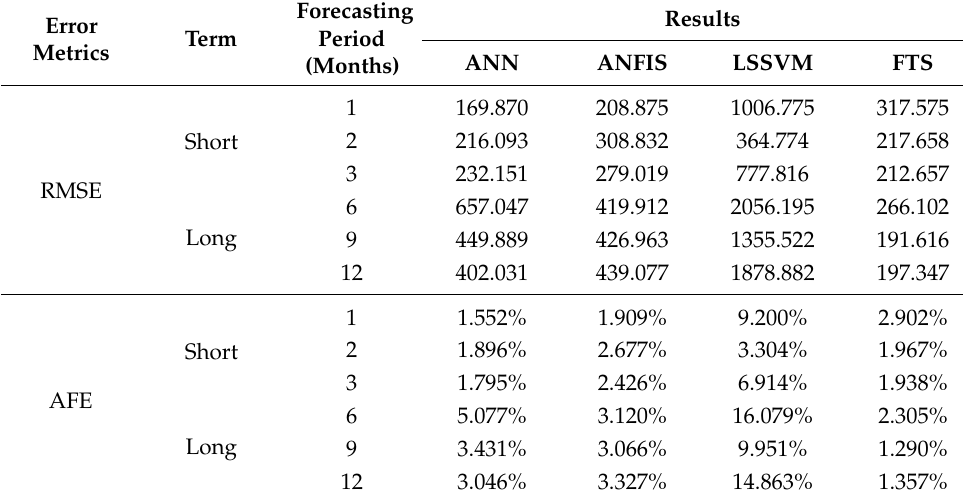
Table 7. Short-term and long-term forecasting results for Malaysia.